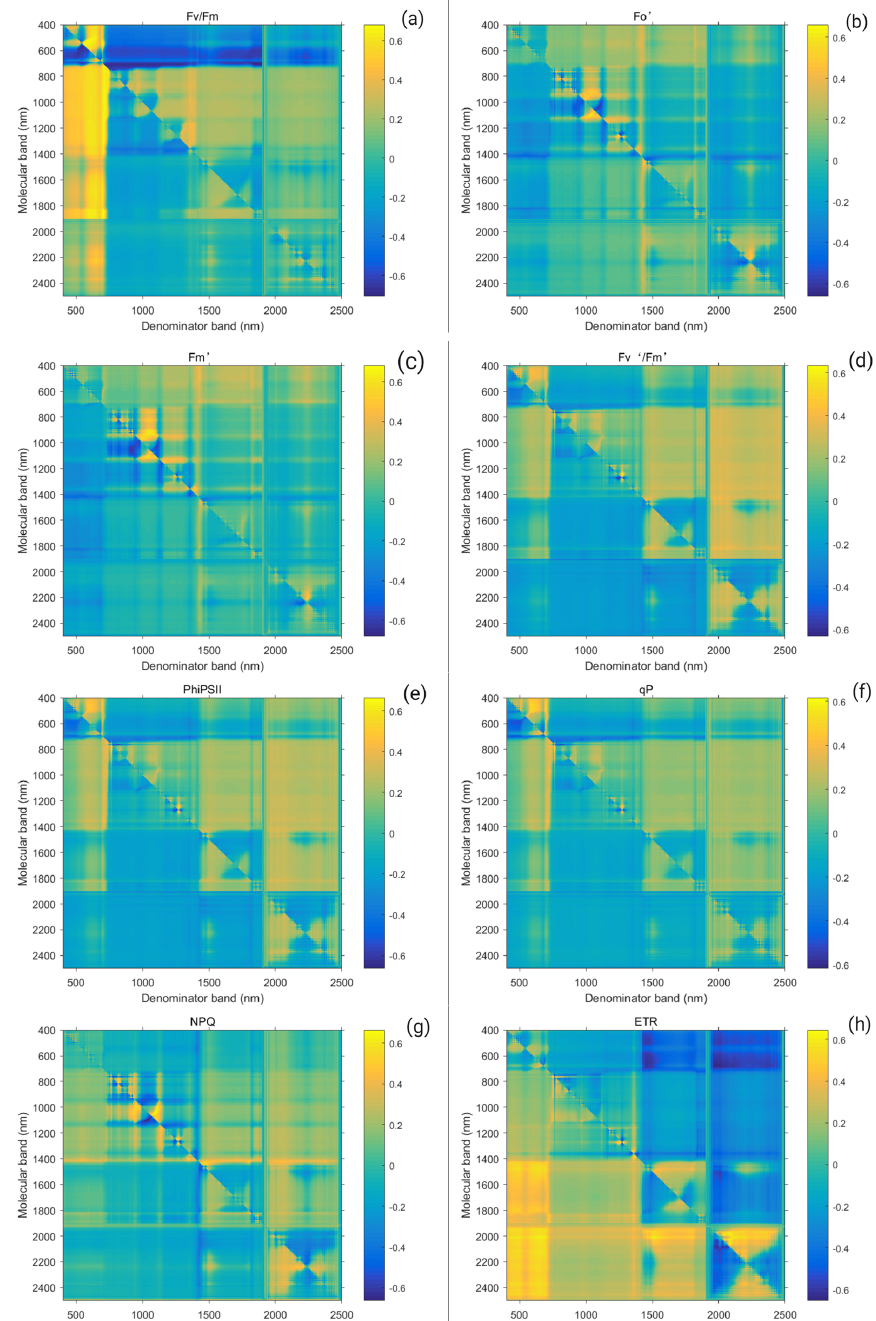
Figure 8. Correlation coefficient of chlorophyll fluorescence parameters( 𝐹𝑣/𝐹𝑚 (a) 、 𝐹𝑜’ ( b ) 、 𝐹𝑚’ ( c ) 、 𝐹𝑣’/𝐹𝑚’ ( d ) 、 𝛷𝑃𝑆𝐼𝐼 ( e ) 、 𝑞𝑃 ( f ) 、 𝑁𝑃𝑄 ( g ) 、 𝐸𝑇𝑅 ( h ))and spectral ratio coefficient under water and salt conditions.